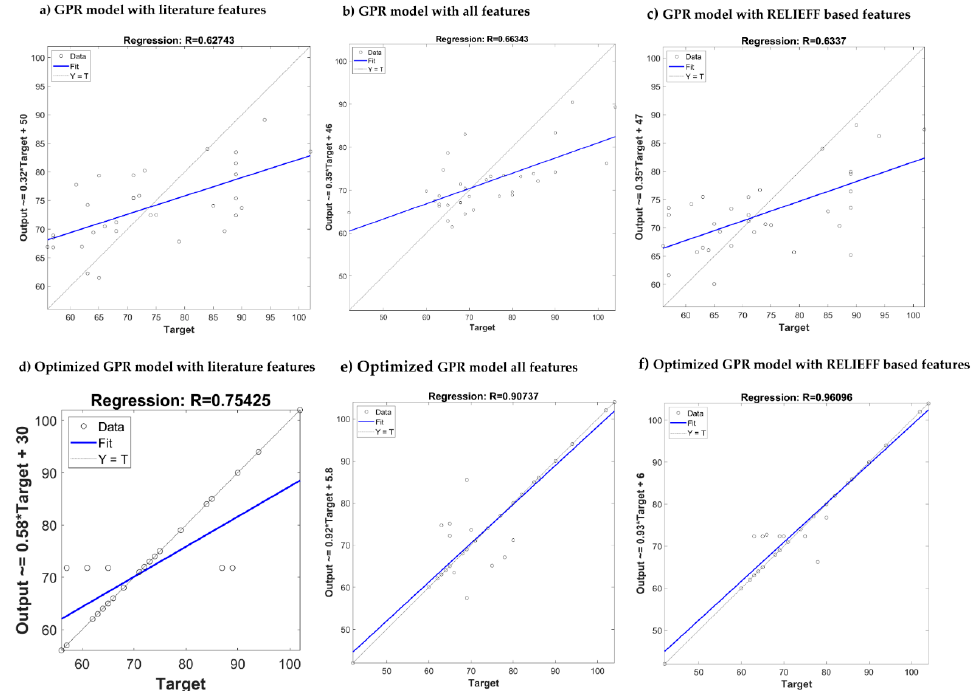
Figure 15. Comparison of the predicted output vs. actual target for DBP estimation using different GPR: ( a–c ) Models without optimization, ( d–f ) models with optimization.